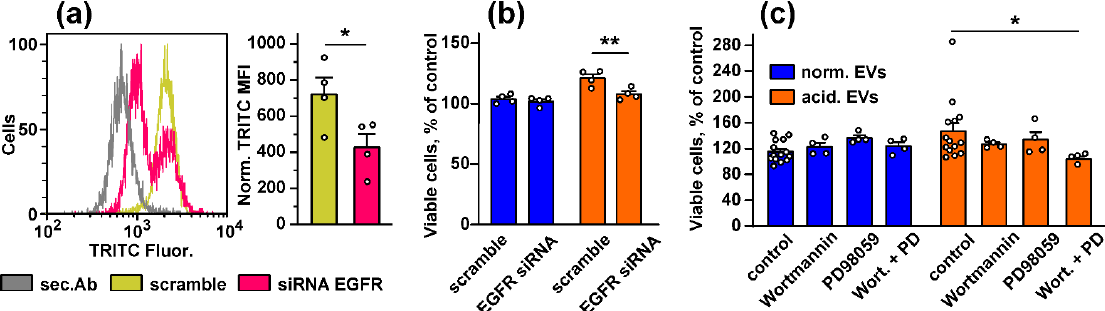
Figure 6. Influence of the EGFR knock-down and inhibition of the PI3K/AKT/mTOR and MEK/ERK pathways on stimulated growth of the keratinocytes induced by EVs. ( a ) Analysis of the EGFR knock- down in the keratinocytes. The representative cell distribution histograms after transfection of the keratinocytes by scramble siRNA and EGFR-specific siRNA and quantification of the EGFR expression are shown on the left and right panels, respectively. Data presented as normalized MFI ± SEM ( n = 4). * ( p < 0.05) indicates significant difference between the data groups by the two-tailed t -test; ( b ) influence of the EGFR knock-down on viability of the keratinocytes stimulated by “normal” and “acidified” EVs. Data are % of the untreated cells ± SEM ( n = 4–14), ** ( p < 0.01) indicates significant difference between the data groups by the two-tailed t -test; ( c ) influence of the inhibitors of the PI3K/AKT/mTOR and MEK/ERK pathways (Wortmannin and PD98059, respectively) on the effects of “normal” and “acidified” EVs on viability of the keratinocytes. Control is the cells treated by only EVs (without the inhibitors). Data are % of the untreated cells ± SEM ( n = 4–14); * ( p < 0.05) indicates the significant difference between the data groups by the one-way ANOVA followed by Dunnet’s post hoc